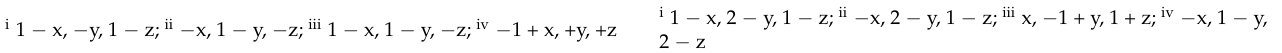
Figure 3. Packing of 1 in the bc plane. Polyhedra of Sm1 are colored orange, while Sm2 ones are light blue. Hydrogen atoms and crystallization water molecules are omitted for clarity. Crystallization water molecules occupy the free space between the sheets and are involved in H-bonds, in particular with the uncoordinated O atoms. This is shown in Fig- ure S5. Previously reported structures with formula [Ln 2 (tda) 3 (H 2 O) 2 ] exhibit the identical molar ratio Ln:tda found in 1 and 2 [59–61]. They crystallize in the same triclinic space group P 1 � , contain two crystallographically non-equivalent Ln atoms, and also present a 2D structure. It is interesting to compare the Ln-S distances. They are 3.105 and 3.091 Å for Dy [59,60], 3.105 Å for Eu [61], 3.098 Å for Gd [60], 3.122 Å for Sm [59], and 3.099 Å for Tb [60]. These values have not been considered as a bond distance, except in the Eu struc- ture. Assuming that an Ln-S bond is present, Ln1 is coordinated by eight oxygen atoms (all of them from carboxylate groups) and one sulfur atom, and Ln2 is coordinated by nine O atoms, two of them from coordinated water molecules. From the ligand point of view, two coordination modes are present, as shown in Scheme 1.